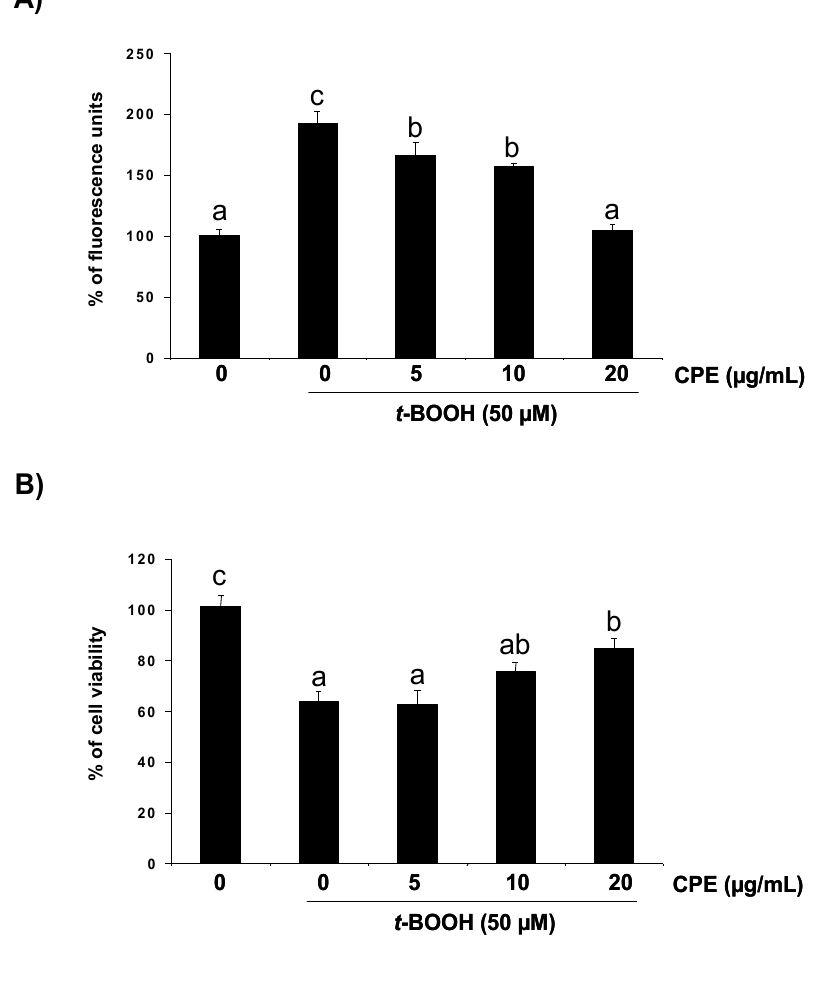
Figure 2. Protective effect of CPE on intracellular ROS generation and cell viability. Ins-1E cells were treated with 5–20 μg/mL CPE for 20 h and then treated with 50 μM t -BOOH for 2 h and ROS ( A ) and cell viability ( B ) were determined. Values are means ± SD of 7–8 different samples per condition. Values are expressed as a percent relative to the control condition. Different letters upon symbols indicate statistically different data ( p <